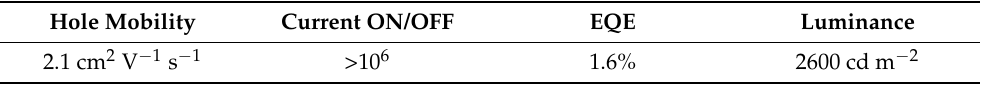
Figure 3. ( a ) Optical transfer characteristic of the LEFET showing luminance versus gate voltage, ( b ) external quantum efficiency (EQE) versus gate voltage and ( c ) EQE versus Luminance. Table 1. Key results of the light-emitting field-effect transistor